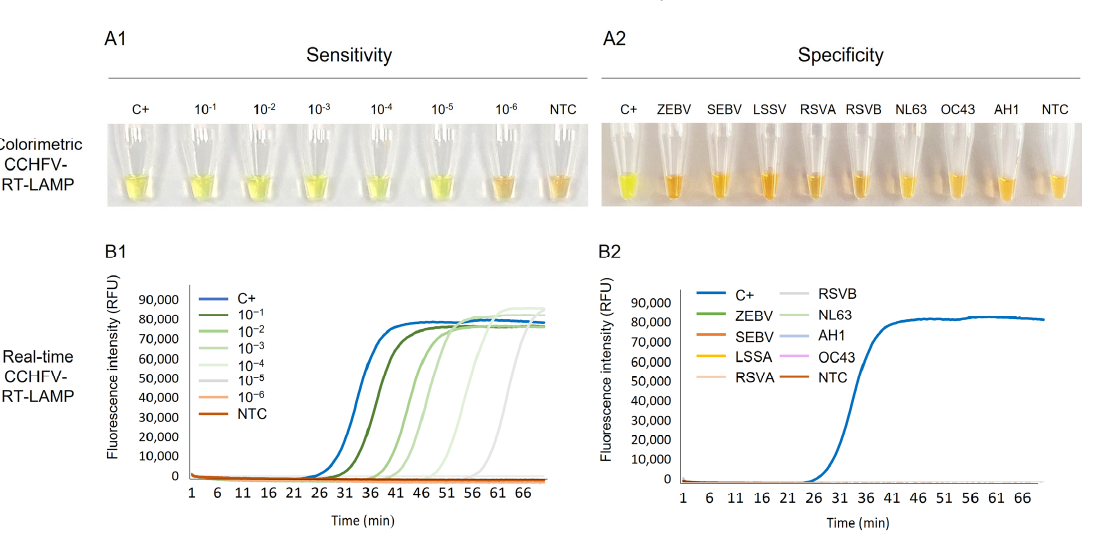
Figure 1. RT-PCR verification, sensitivity and sequencing using outer primers F3 and B3 for CCHFV RNA amplification. ( A ) Verification and detection limit of RT-PCR F3-B3. Lane MWM, molecular weight marker (100 bp Plus Blue DNA Ladder); lane C+, RNA isolate from patient P5 used as positive control; lanes 10 − 1 –10 − 6 , 10-fold serial dilutions of C+; lane NTC, non-template control (RNase-free water instead of RNA). ( B ) Comparison of 212 bp amplicon obtained (P5; C+) with partial sequence of Daral 2012 strain (GenBank KF793333). Grey arrows indicate different nucleotides in the sequence.